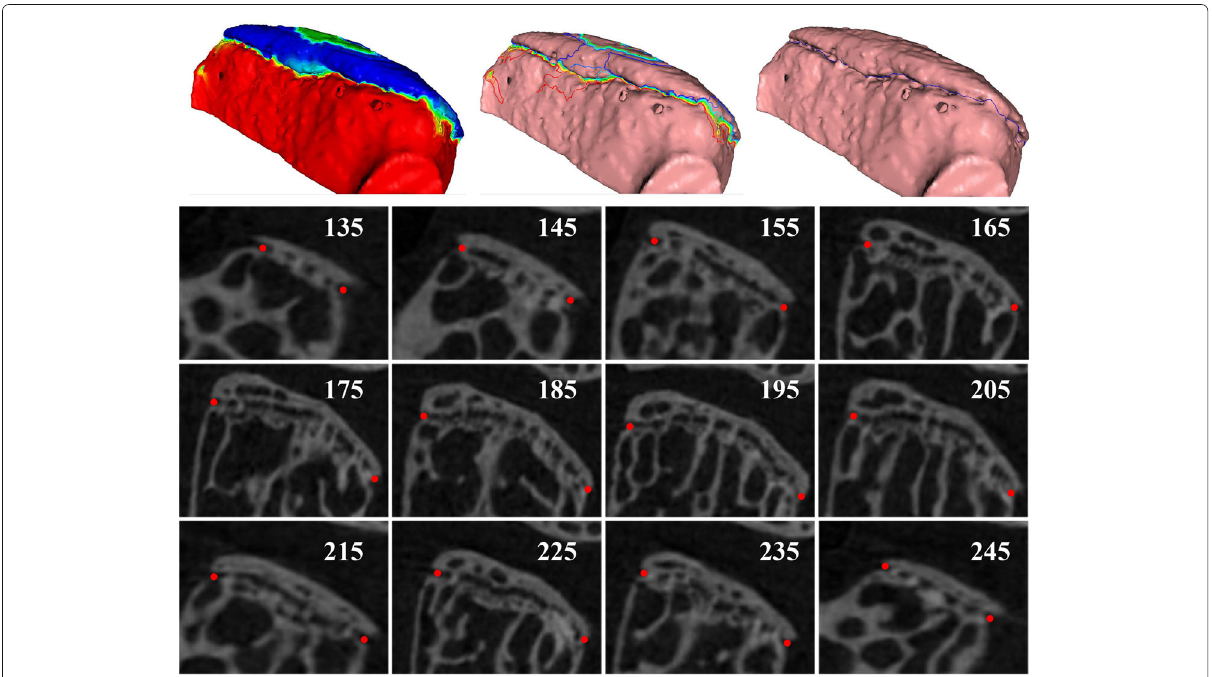
Fig. 11 Experimental results of shape priori extraction. The generated harmonic field, isoline candidates and the resulting 3D gap line of a randomly selected vertebra are shown in the first row from left to right respectively. The rest part shows the terminal points corresponding to the 3D gap line within some typical slices